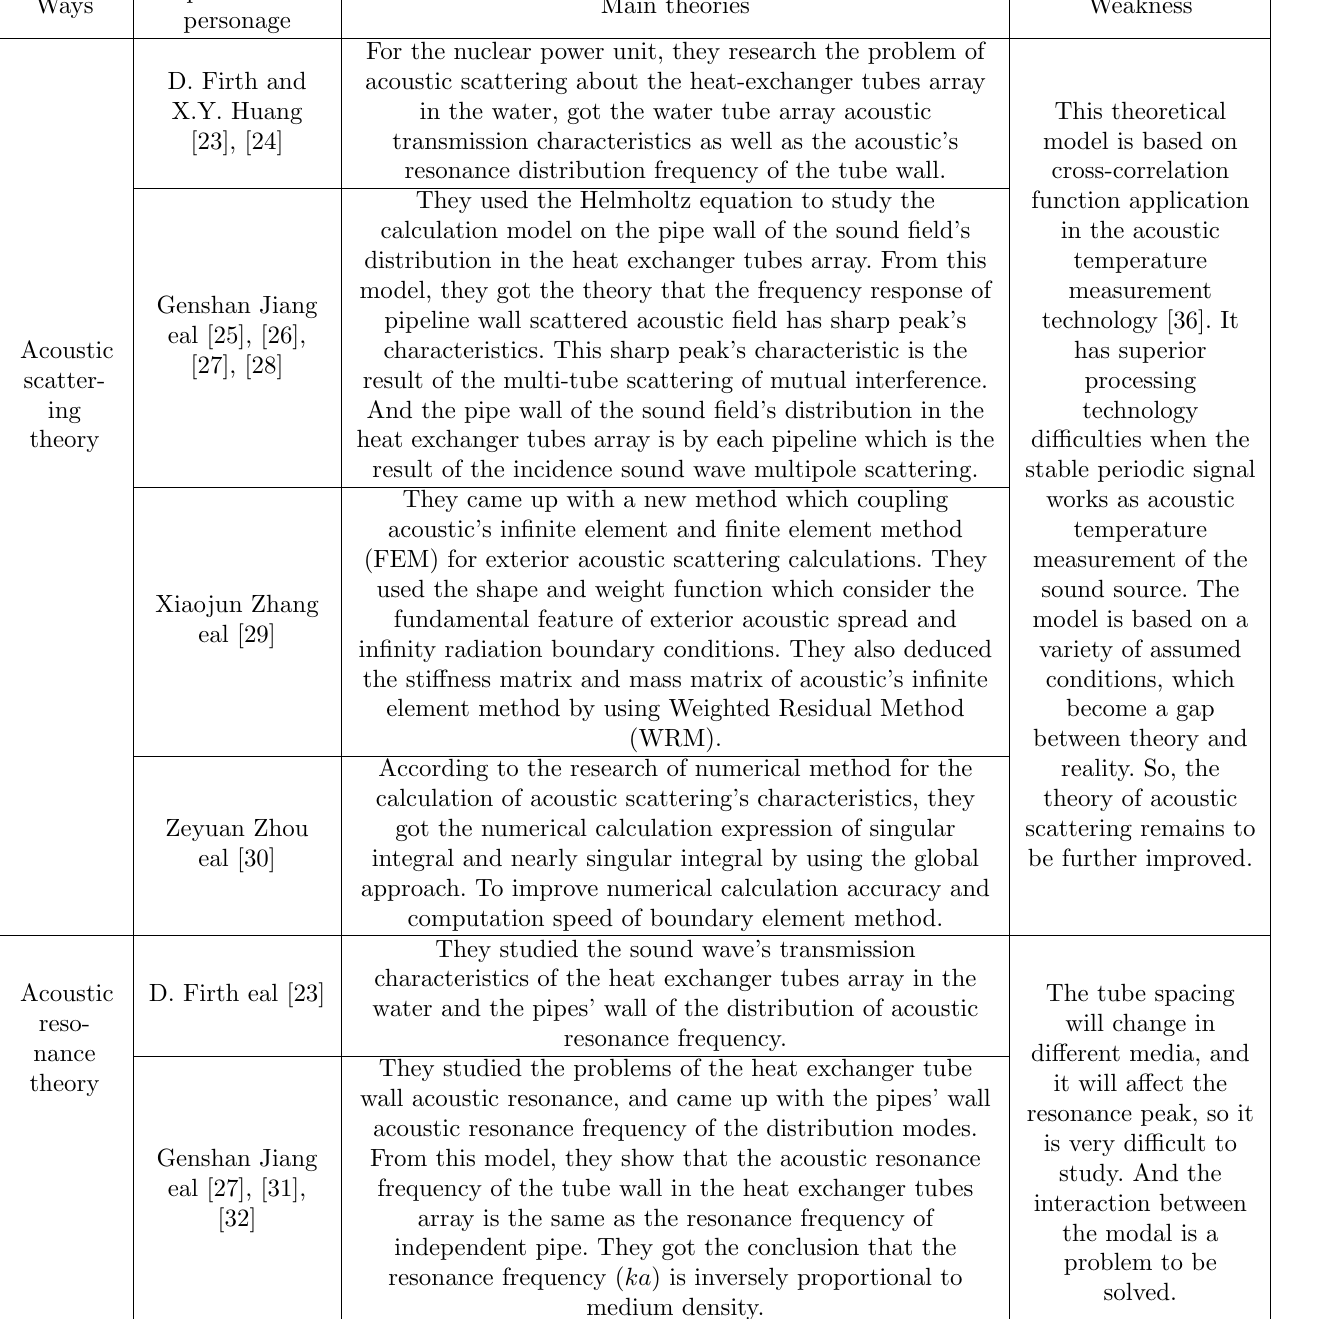
Table 3. The development status of the acoustic scattering and acoustic resonance